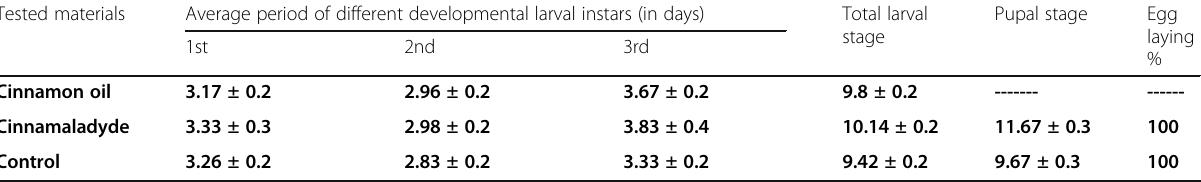
Table 2 Effect of different tested materials indirectly on the biological aspects of Chrysoperla carnea Tested materials Average period of different developmental larval instars (in days) Total larval